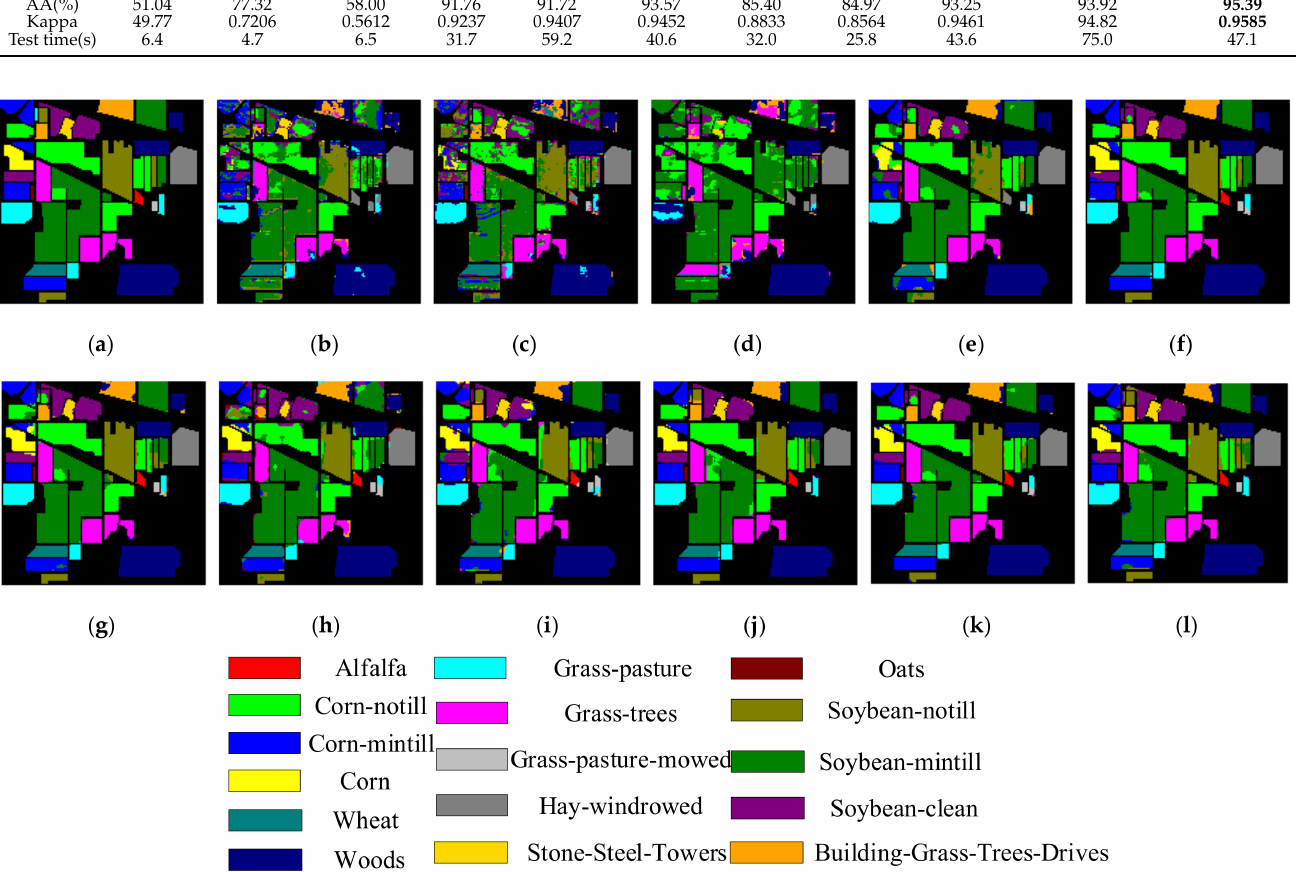
Figure 7. Full classification maps on the Indian Pines image obtained with the ( a ) ground truth, ( b ) KNN (OA = 55.61), ( c ) SVM-RBF (OA = 77.58), ( d ) CDCNN (OA = 62.20), ( e ) SSRN (OA = 93.32), ( f ) FDSSC (OA = 94.79), ( g ) DHCNet (OA = 95.19), ( h ) DBMA (OA = 89.78), ( i ) HybridSN (OA = 87.46), ( j ) DBDA (OA = 95.45), ( k ) LiteDepthwiseNet (OA = 95.59), and ( l ) proposed method (OA =